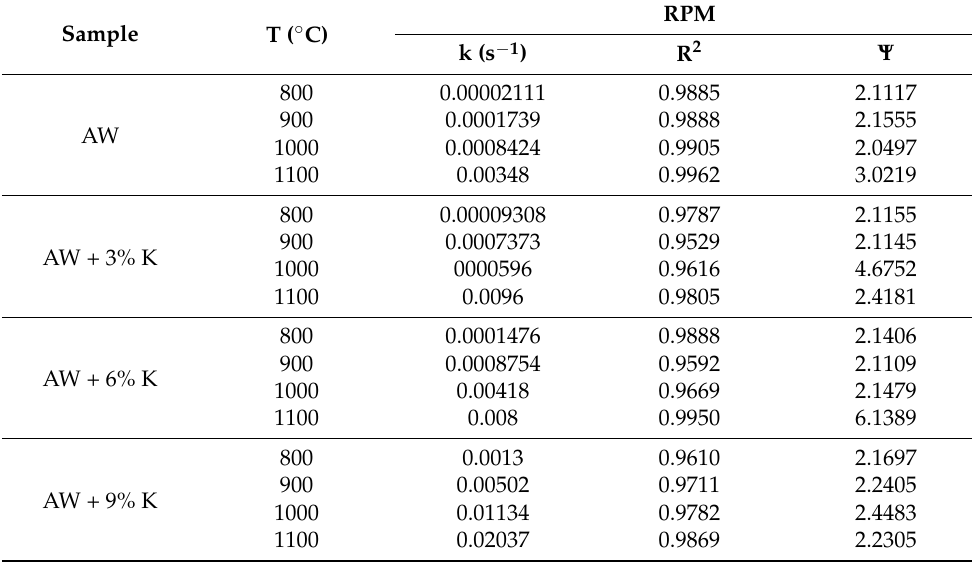
Figure 4. Plots fitting the RPM model for coal char with different KCl concentration. Table 3. Summary of kinetic and empirical parameters of the RPM model.